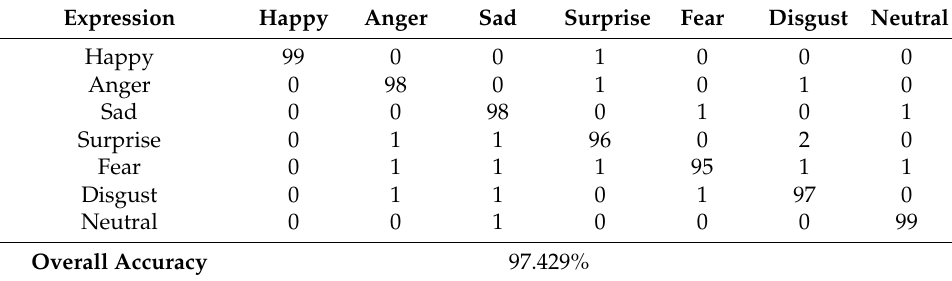
Table 3. Facial Expression confusion matrix using Cohn-Kanade dataset (unit %).